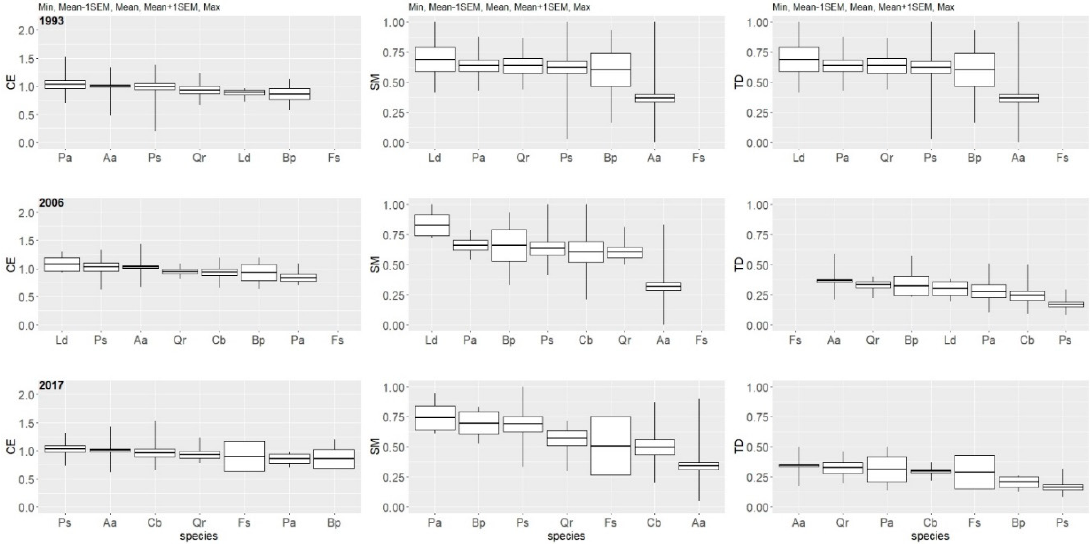
Figure 11. Species-specific indices of spatial positioning, spatial mingling, and spatial diameter differentiation for specified years in the multispecies, uneven-aged forest located in the Unieszów Forestry Range.